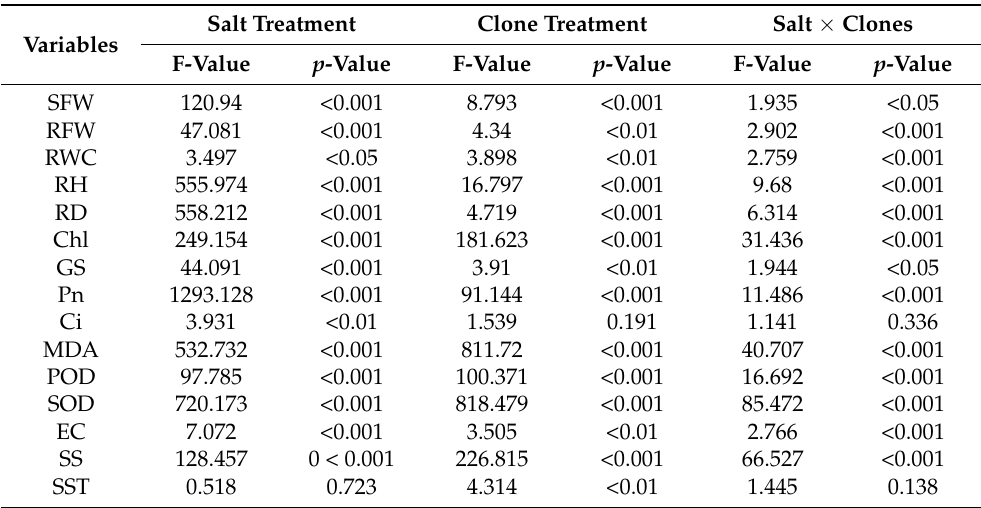
Table 2. ANOVA analyses of effects of salt and clone treatments and their interaction on the growth, biomass, photosynthetic, physiological, and biochemical of Salix matsudana